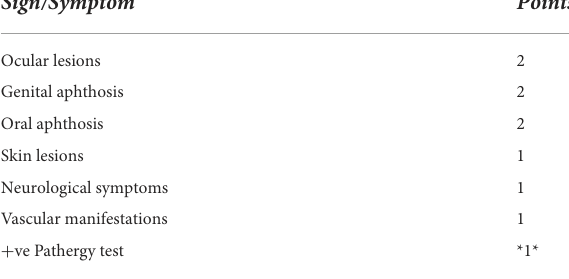
TABLE 1 International criteria for Behçet’s disease—point score system: scoring > 4 indicates Behçet’s diagnosis (14). Sign/Symptom